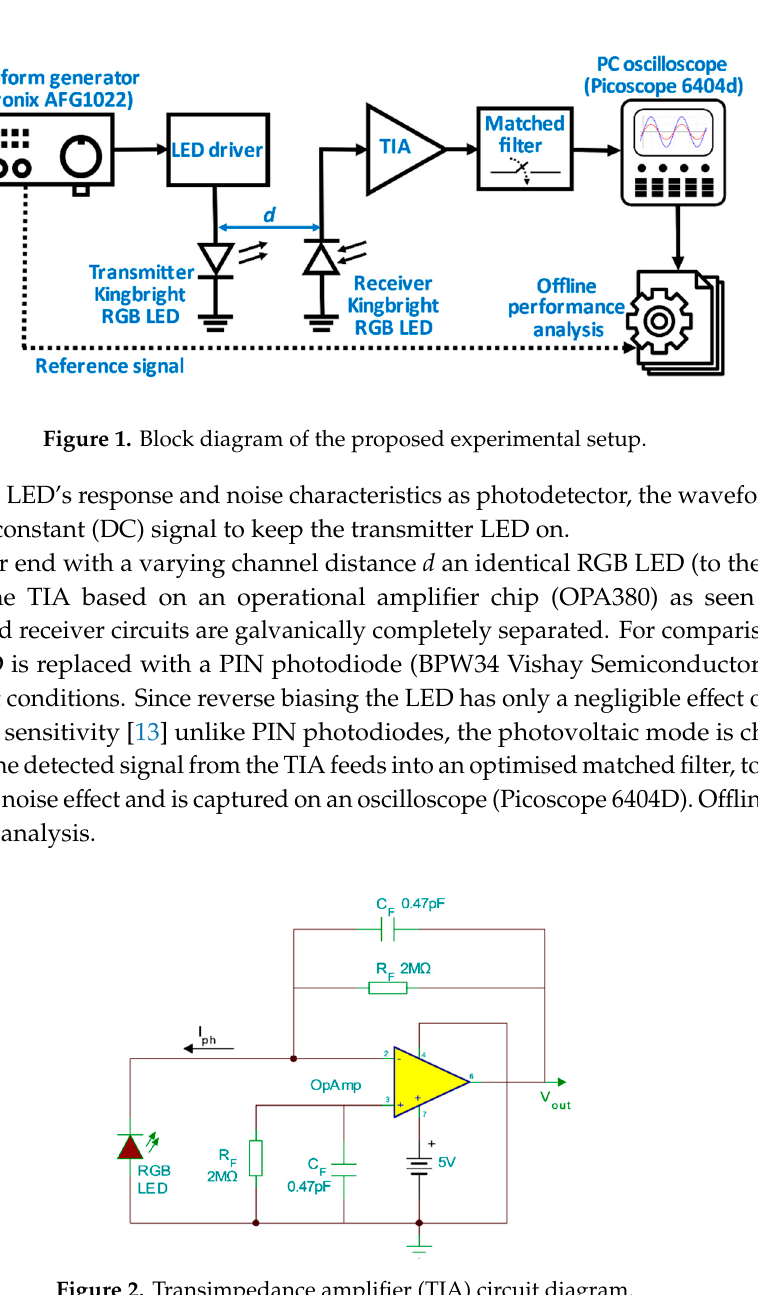
Figure 2. Transimpedance amplifier (TIA) circuit diagram.